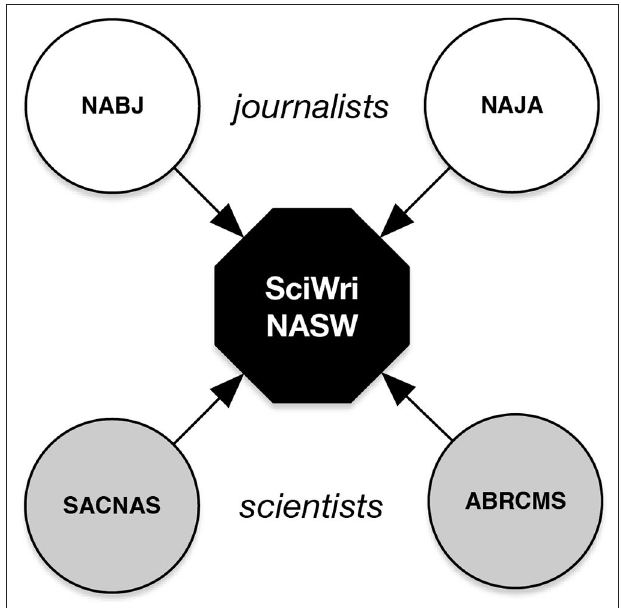
FIGURE 4 | Schematic of the two minority populations targeted as applicants for the travel fellowship to attend the ScienceWriters (SciWri) annual conference that is produced by the National Association of Science Writers (NASW). Minority journalists were solicited from the National Association of Black Journalists (NABJ) and the Native American Journalists Association (NAJA). The fellowship opportunity was also publicized among minority scientists of the Society for the Advancement of Chicanos and Native Americans in Science (SACNAS) as well as the Annual Biomedical Research Conference for Minority Students